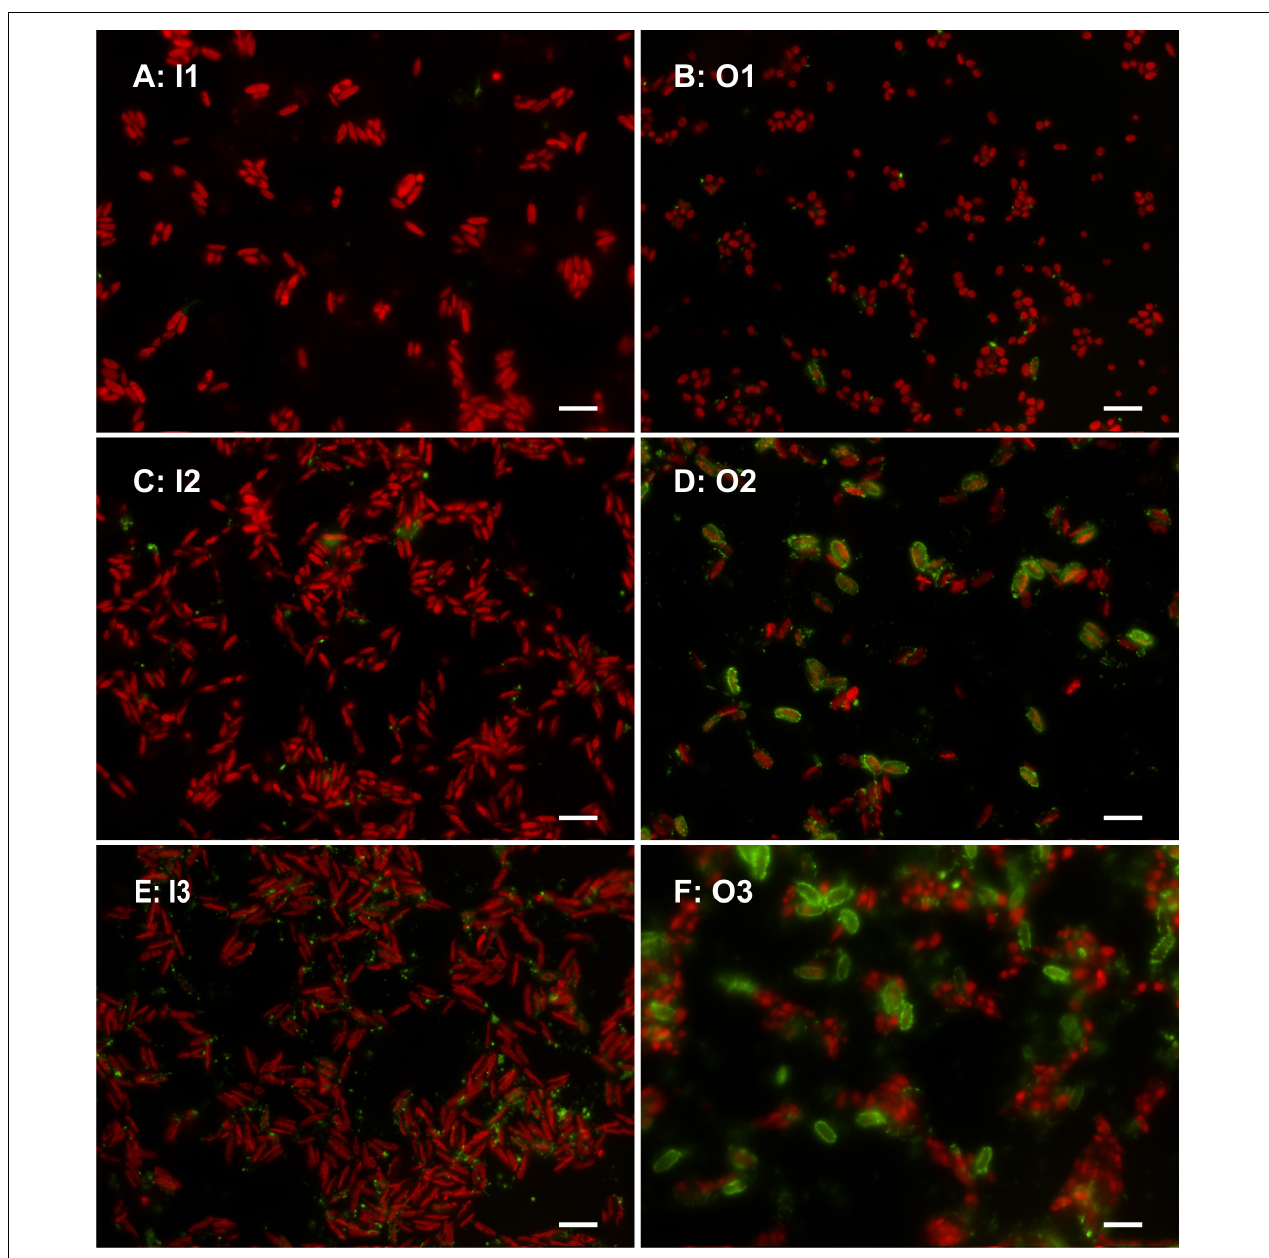
FIGURE 4 | Microphotographs of the C. elongata cultures grown in all experimental treatments (see variants’ codes), i.e., in P-replete (top: A,B ) and P-depleted (middle and bottom: C–F ) media with inorganic (left) or organic (right) P sources. Combined images in artificial colors (for details, see Figure 1 ); scale bars represent 10 µ